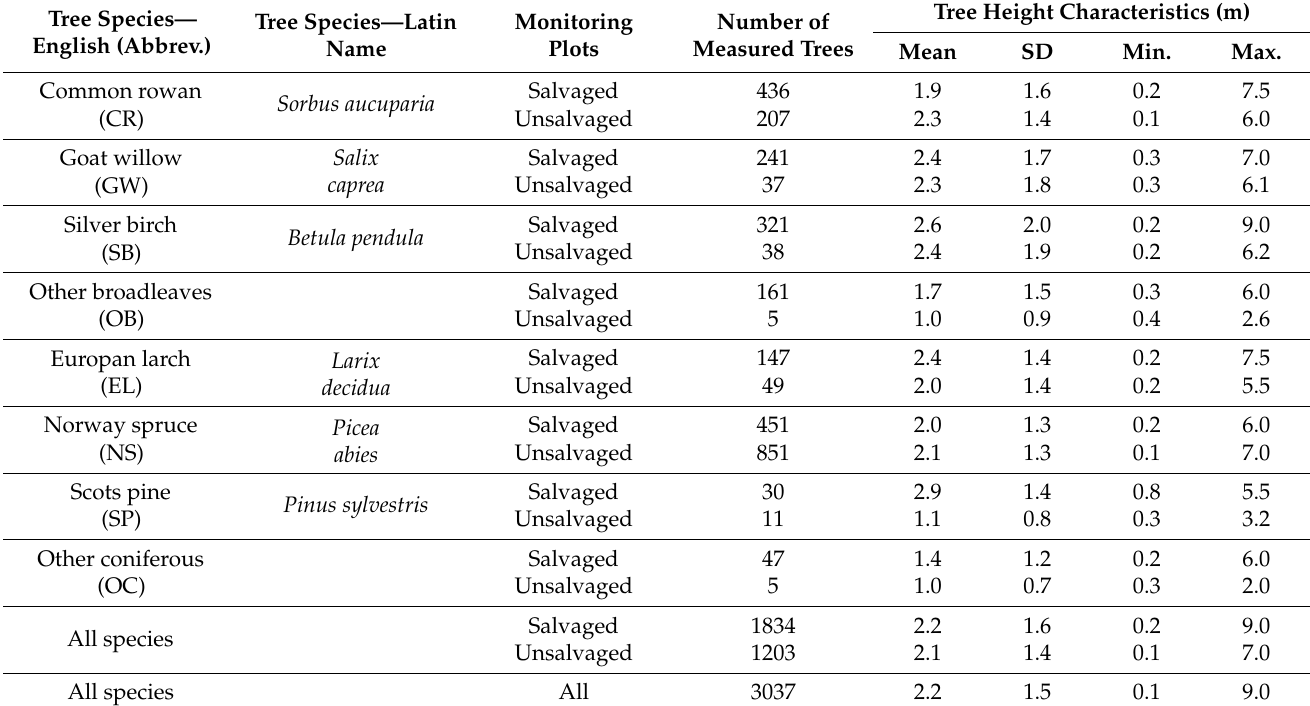
Table 2. Tree height characteristics for the salvaged and unsalvaged monitoring plots by tree species (the High Tatra Mts. in